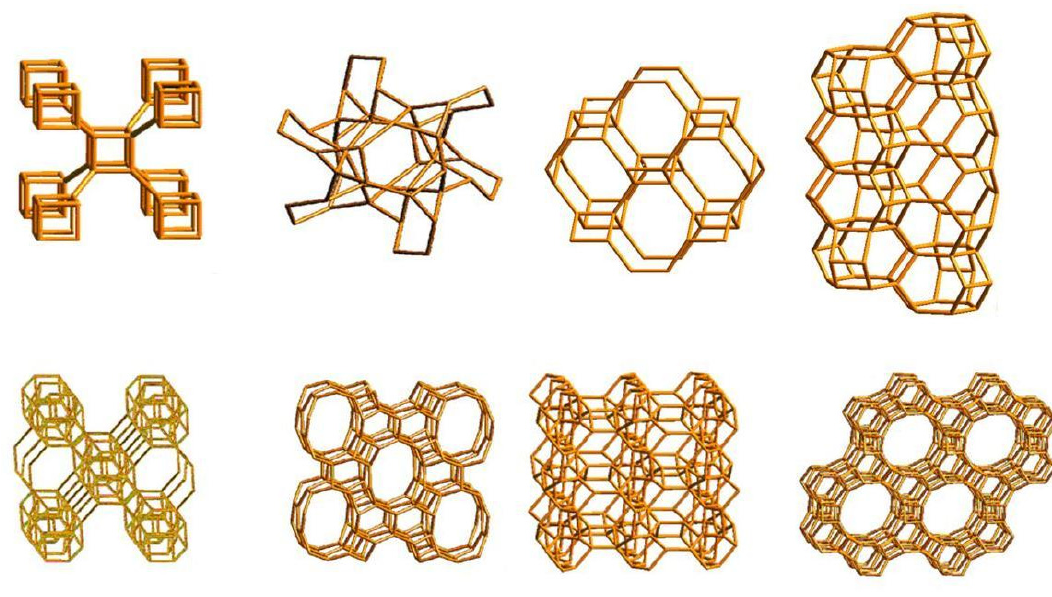
Figure 1. Molecular sieves. Microporous molecular structures of some Zeolites are shown into their atomistic representations. Image modified from Atlas of